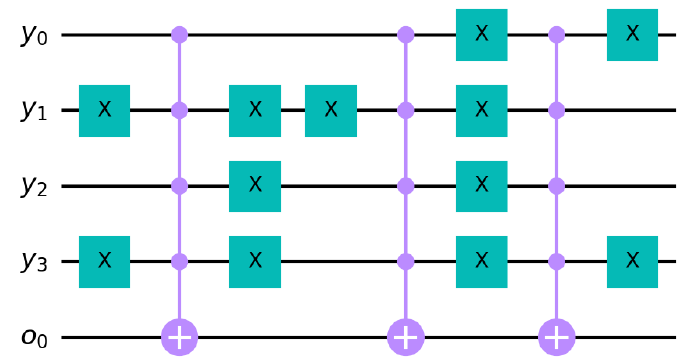
Figure 19. Encoded obstacles of Figure 13, the first obstacle is in position ( 01,01 ) , the second in position ( 01,10 ) , the third in ( 10,01 )